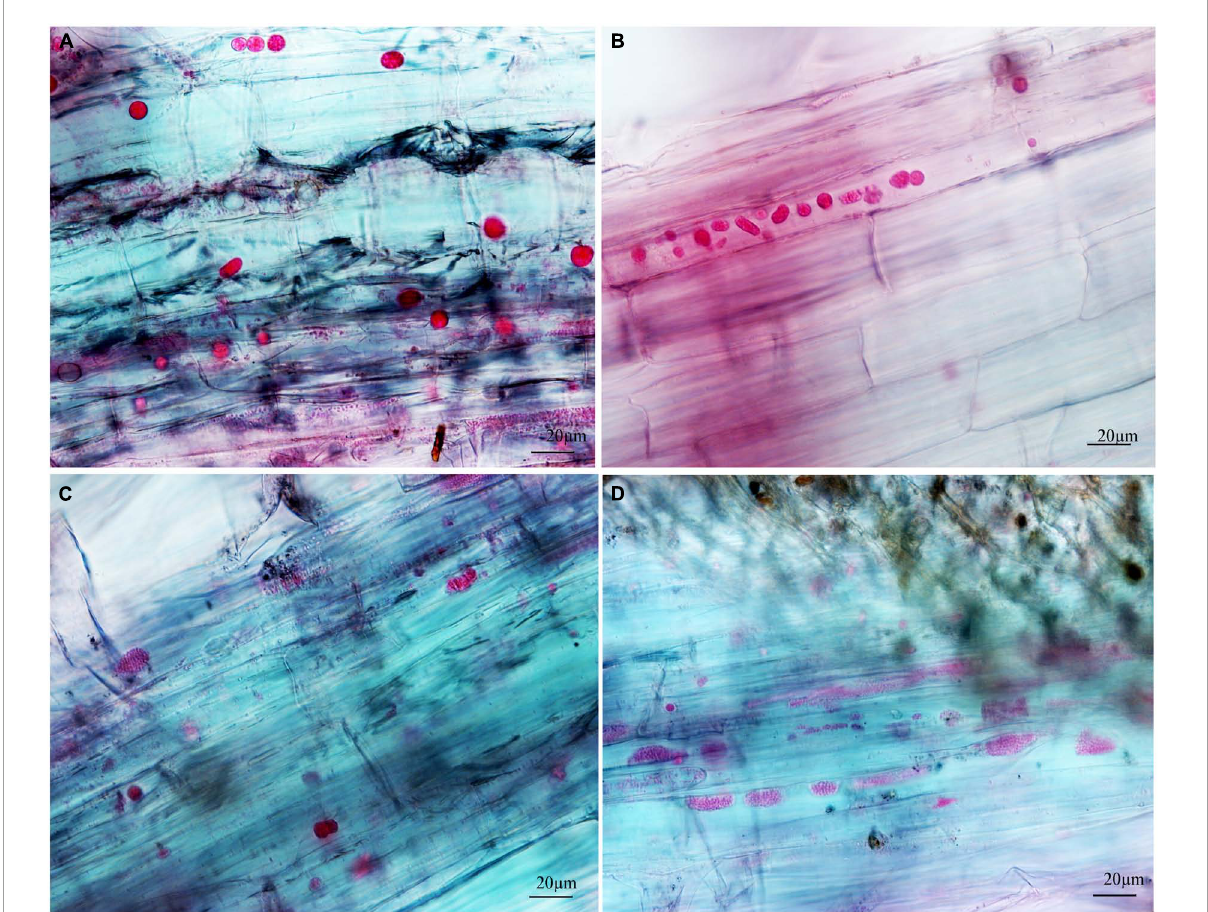
FIGURE3 The developmental asynchrony of P. brassicae in cabbage inoculated with resting spores at 12 dpi. (A) The spherical secondary plasmodia with a visible membrane boundary. (B) The oblong and amorphous secondary plasmodia with a clear or unclear visible membrane boundary. (C) The resting sporangial plasmodia. (D) The resting sporangial plasmodia with no clear visible membrane boundary and many resting